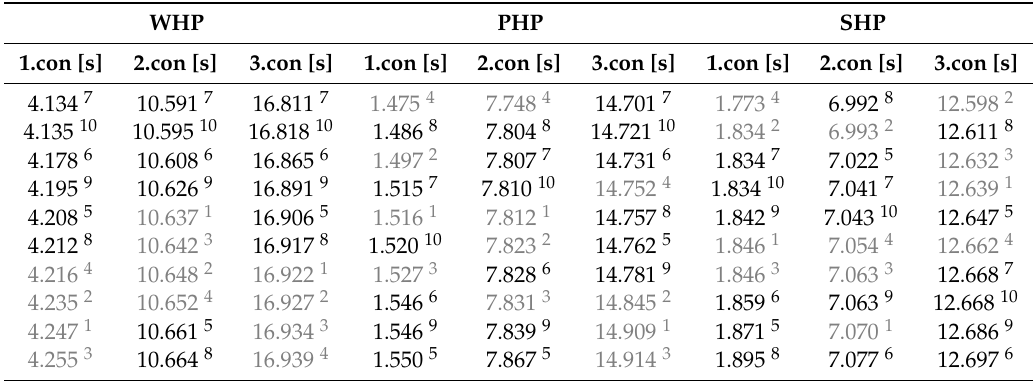
1,2,3,4 Number of the channel on the muscle vastus medialis; 5,6,7,8,9,10 Number of the channel on the muscle rectus